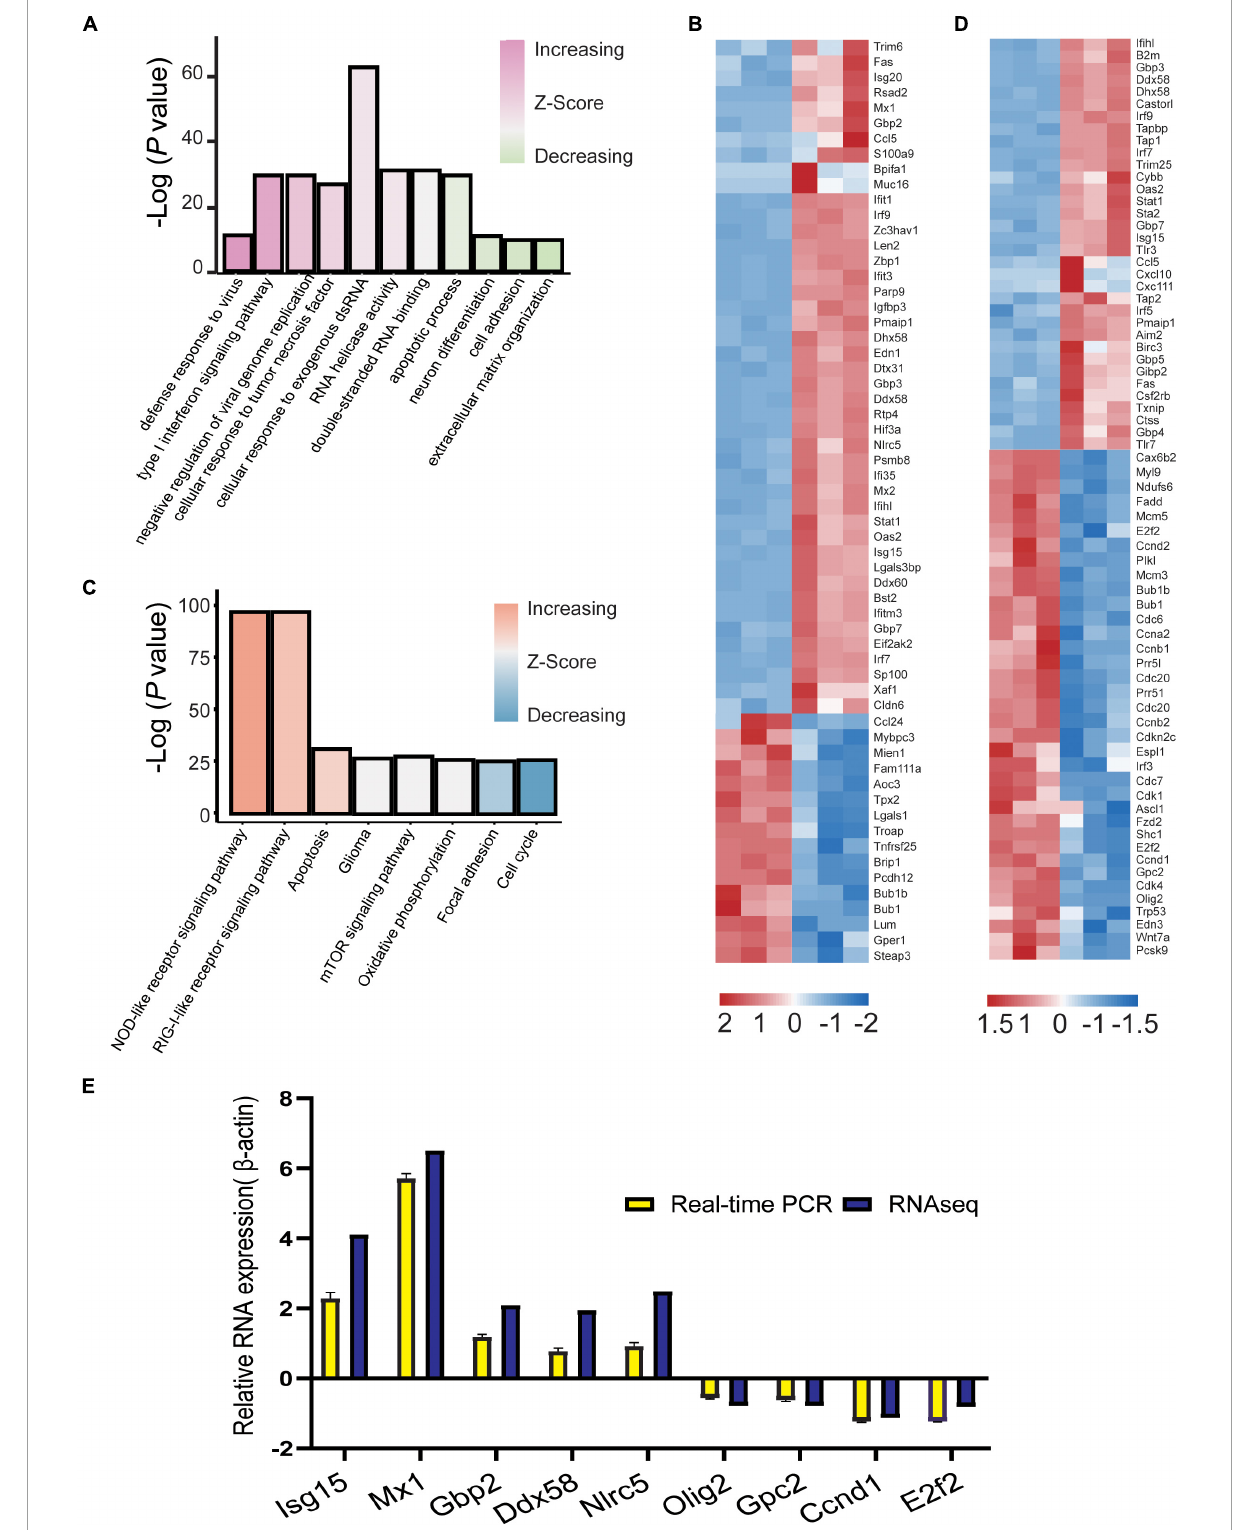
FIGURE5 Visualization of differentially expressed genes (DEGs) in echovirus 30-infected suckling mice brain tissue. (A,C) GO bar plot analysis of DEGs enriched in GO terms in the brain tissue and (B,D) visualization of DEGs enriched in the brain tissue using KEGG. (E) The log 2 fold change of differentially expressed genes in the RNA-Seq data and validation of differentially expressed genes via RT-PCR